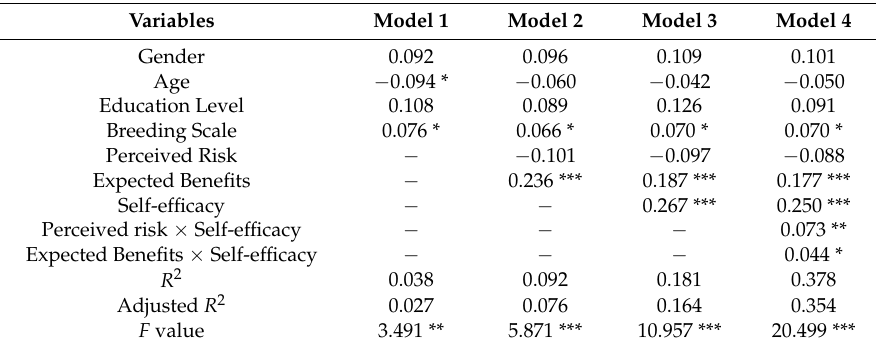
Table 5. Result of hierarchical regression